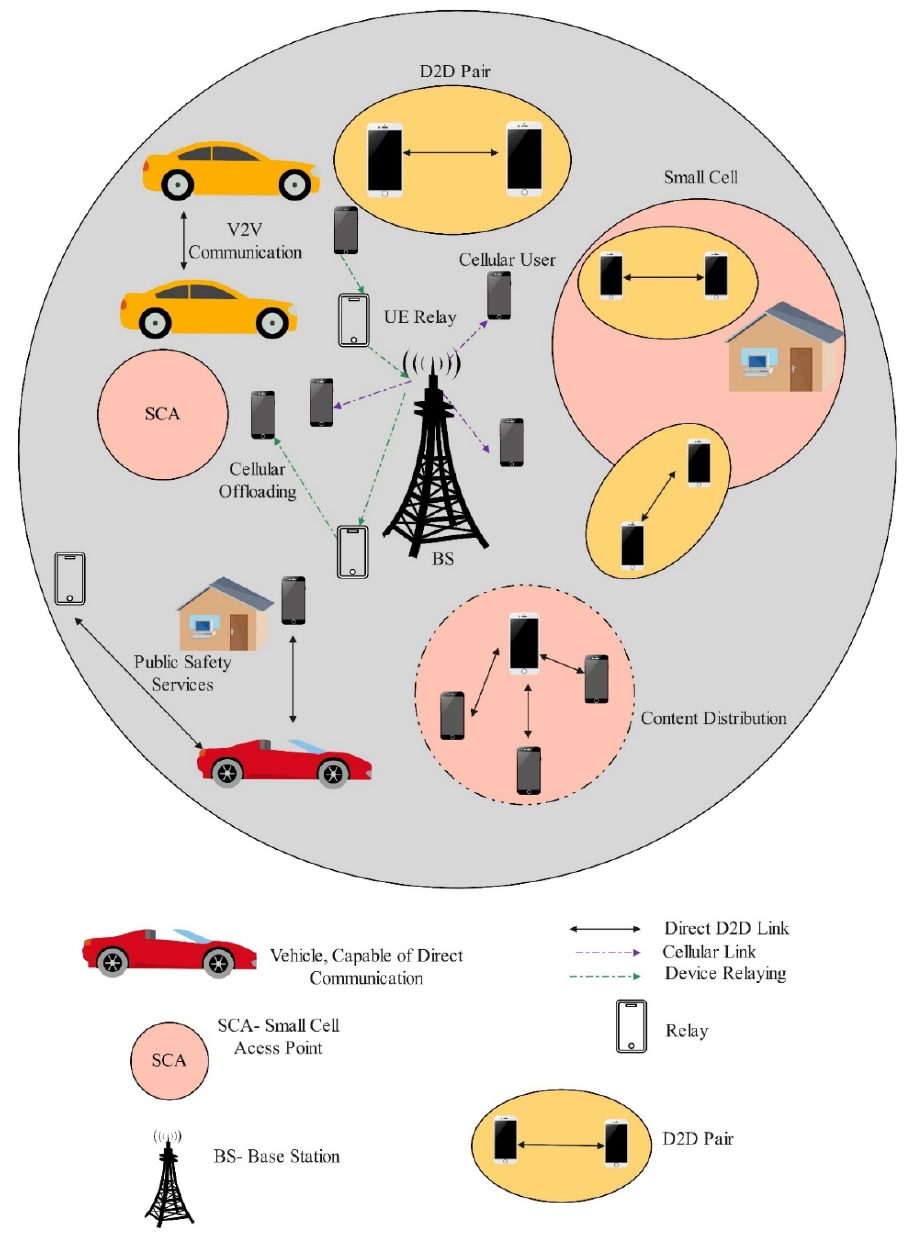
Figure 7. The General Scenario supporting D2D communication.